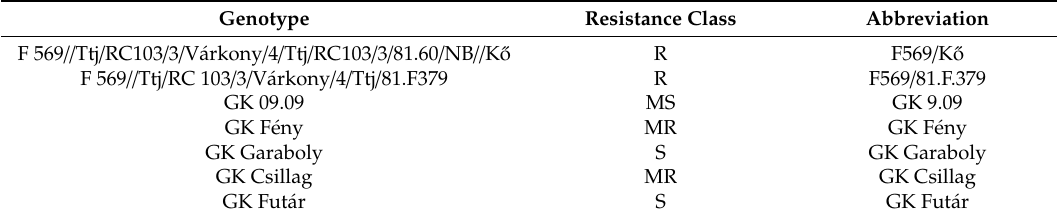
Table 11. Wheat genotypes investigated at Szeged between 2013–2014 and their